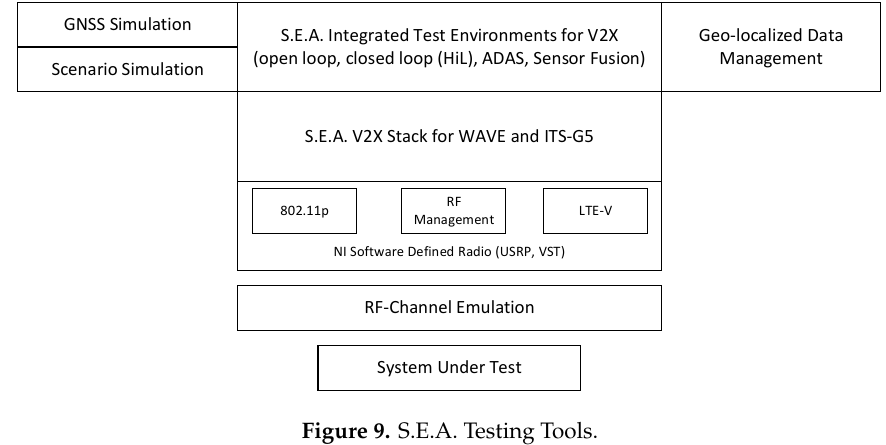
Figure 9. S.E.A. Testing Tools.